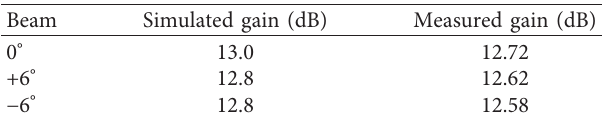
Table 1: Comparison between simulated and measured gain values at 10GHz. Beam Simulated gain (dB)